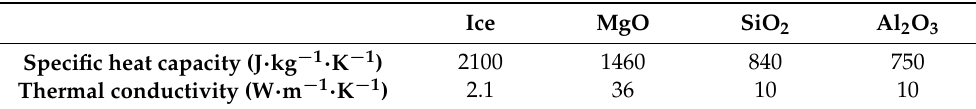
Table 3. Specific heat capacity and thermal